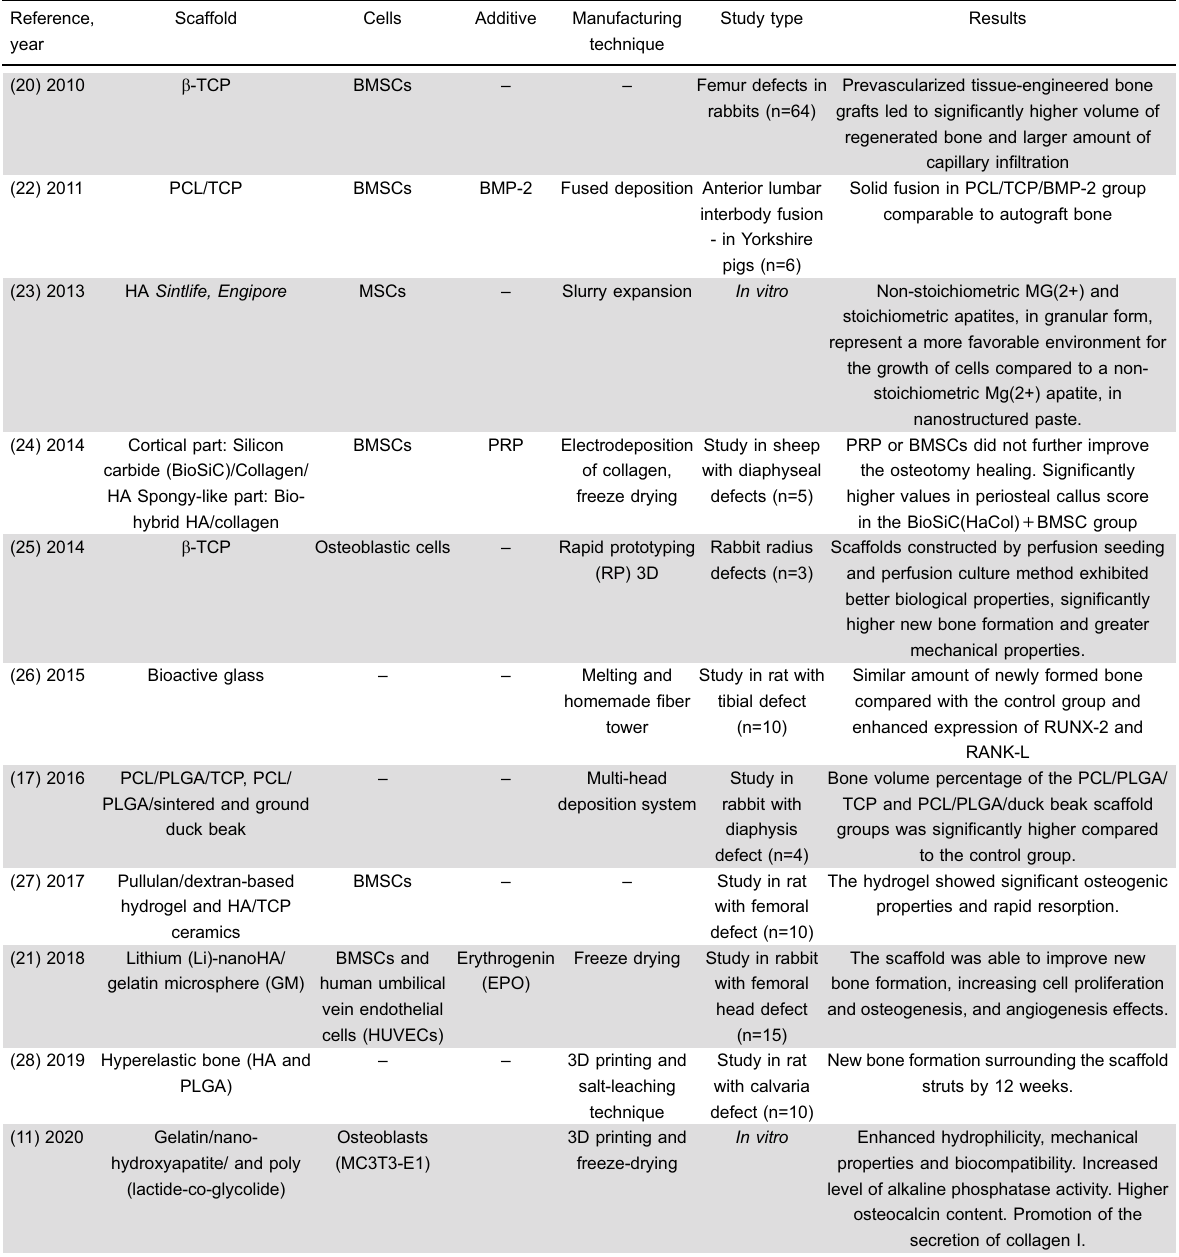
Table 1. Summary of relevant studies involving scaffolds for bone regeneration in the orthopedic fi eld in the last ten years.